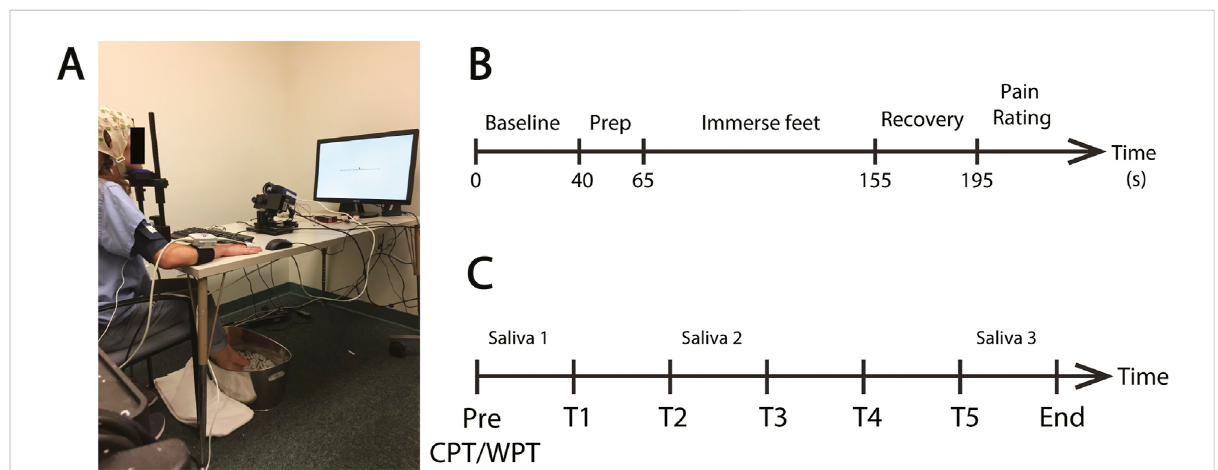
FIGURE 1 Pressor protocol. (A) An example of a fully instrumented participant in the treatment condition. (B) The standard protocol for each CPT or WPT trial.Eachprotocolconsistedofapre-immersionbaselinerecording(40 s)followedbyapreparatoryperiod(25 s)wheretheparticipantwasrequired to position their feet on the edge of the water bucket in preparation for immersion. The participant then lowered their feet into the water (90 s) and removed them from the water for the recovery period (40 s). They then provided a pain rating. (C) Schematic of the complete experiment protocol. Participants completed fi ve CPT exposures on the Treatment Day or fi ve WPT exposures on the Control Day (T1 — T5). The time between the onset of each exposure was ~25 min. Saliva samples were collected prior to T1 and T3 and immediately after